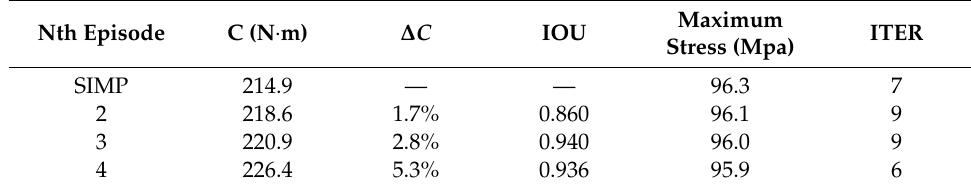
Figure 15. The thickness distribution of four generated options of the upper body of ADS. Table 2. Calculation results of the upper body of ADS